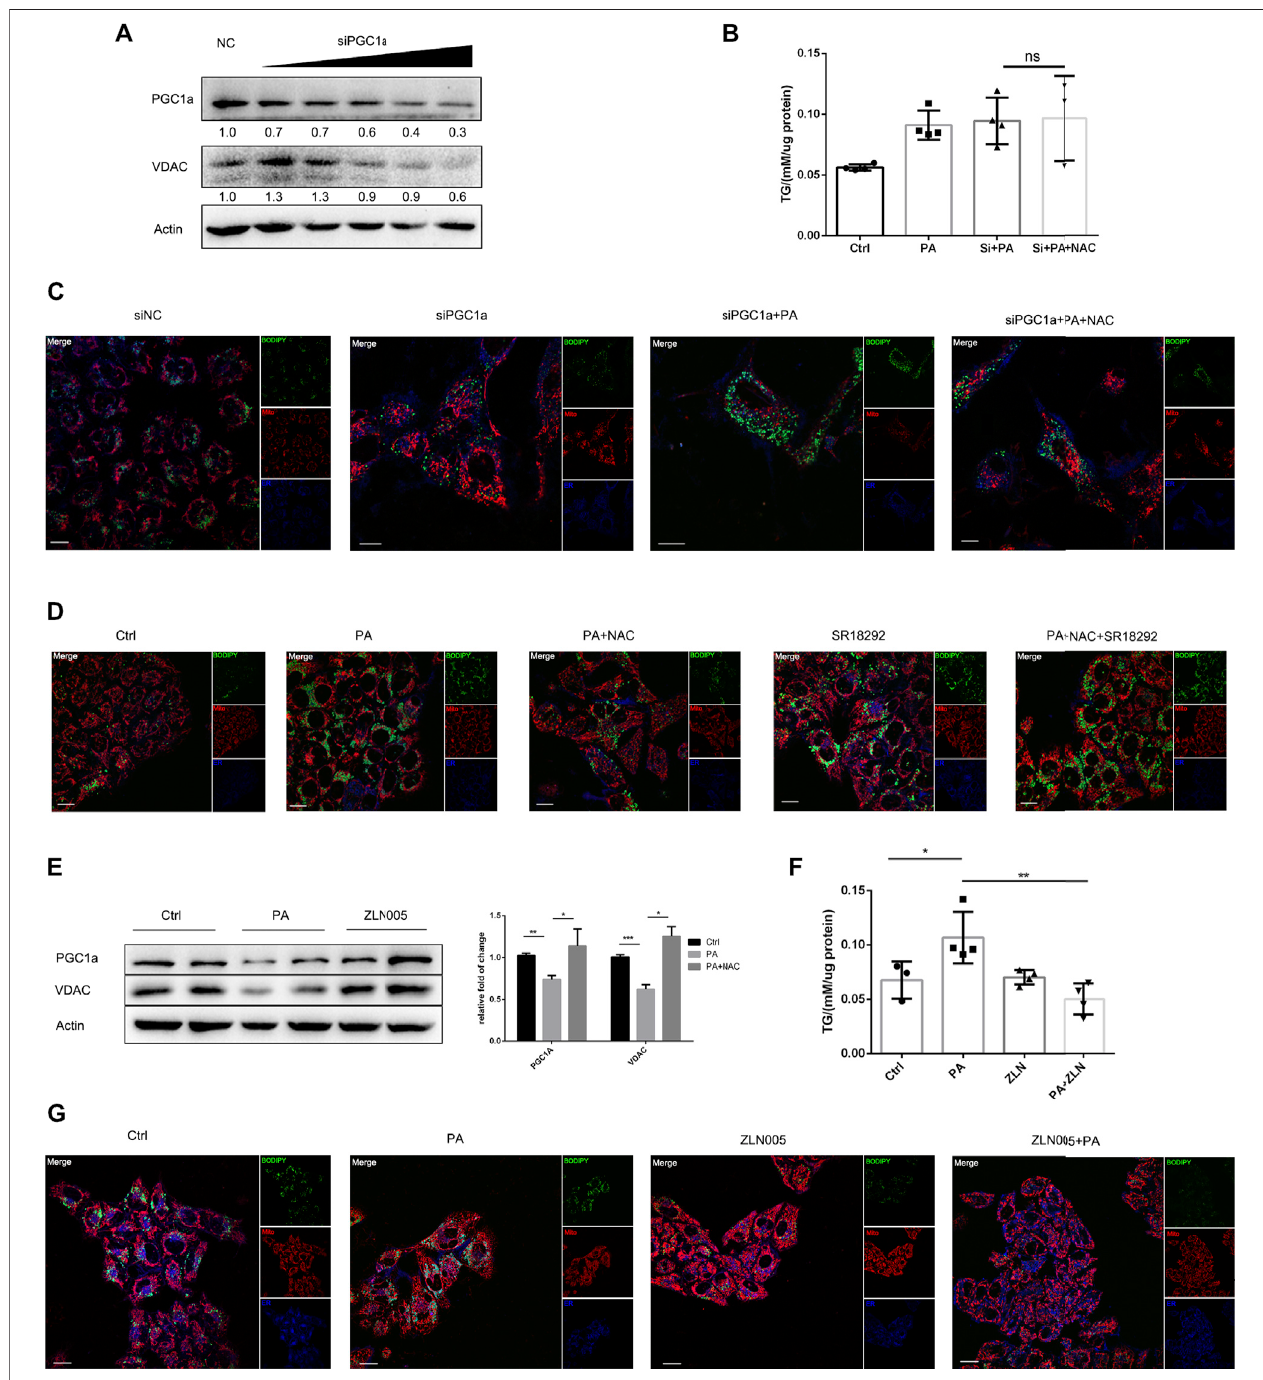
FIGURE 4 | NAC reduced intracellular lipid accumulation via maintaining PGC1a level. (A) Representative Western blot image of PGC1a protein level after transfection with siRNA targeting at PGC1a; (B) intracellular TG concentration of cell in different groups; the concentration was adjusted to protein level; (C,D) BODIPY staining showed a different amount of lipid droplet in cells with PGC1a silenced (C) or pharmacologically inhibited (D) . The green channel was BODIPY, the red channel was mitochondria, and the blue channel was the endoplasmic reticulum (ER). Scale bar was 10 μ m; (E) representative Western blot image of PGC1a and VDAC protein level after ZLN005 stimulation, a PGC1a speci fi c agonist. The experiment was conducted triple; (F) intracellular TG concentration of cell in different groups; the concentration was adjusted to protein level; (G) BODIPY staining showed a different amount of lipid droplet in cells with ZLN005 treatment. The green channel was BODIPY, the red channel was mitochondria, and the blue channel was the ER. Scale bar was 10 μ m (* p < 0.05, *** p < 0.001, and **** p < 0.0001; all the data signi fi cance was analyzed by ANOVA).